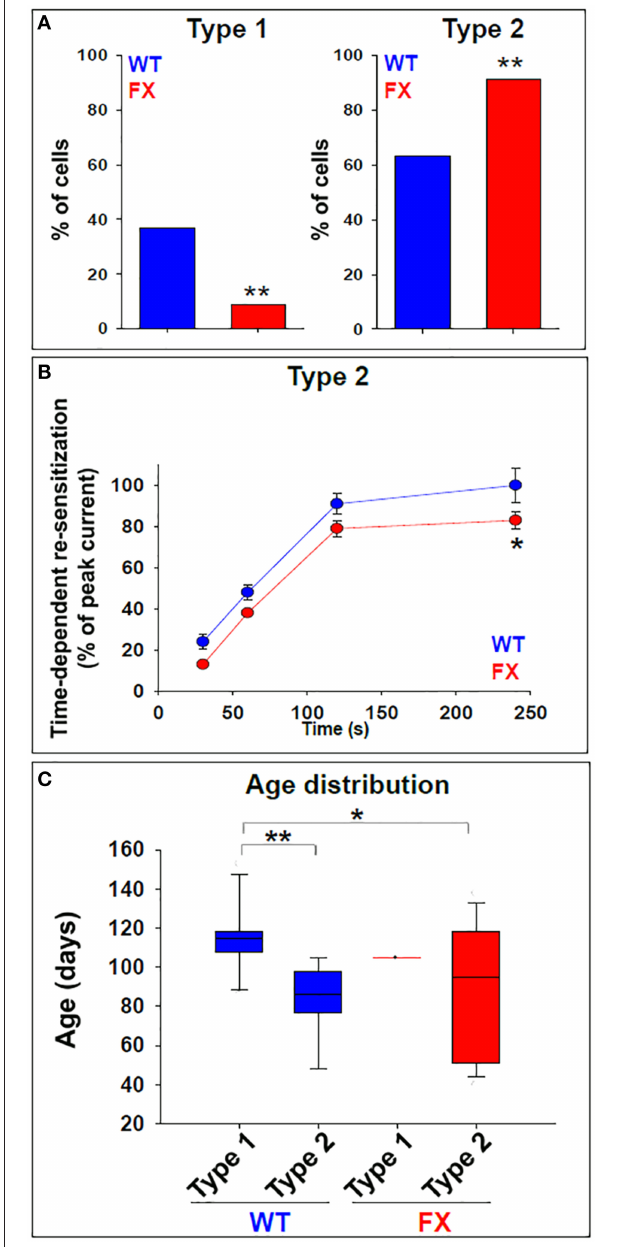
FIGURE 3 | GABA responses in WT and FX neurons. (A) Total incidence of type 1 and type 2 responses to GABA in WT (blue) and FX (red) neurons. Values are the percent of cells in each category out of the total number of cells examined. WT n = 30 , FX n = 35 (FX1 n = 11 , FX2 n = 9 , FX3 n = 15 ). ** p < 0.01 , Chi-square test. (B) Quantification of time-dependent re-sensitization in type 2 responses, in WT (blue) and FX (red) neurons. Values are presented as percent of the peak current obtained with the first GABA pulse (before desensitization). WT n = 30 , FX n = 35 (FX1 n = 11 , FX2 n = 9 , FX3 n = 15 ). Values are mean ± SEM. * p < 0.05 , t -test. (C) Box plot showing distribution of type 1 and type 2 responses in relation to neuronal in-vitro age following differentiation induction, in WT (blue) and FX (red) neurons. WT n = 30 , FX n = 35 (FX1 n = 11 , FX2 n = 9 , FX3 n = 15 ). * p < 0.05 , ** p < 0.01 , Chi-square test. See also Table 1 for